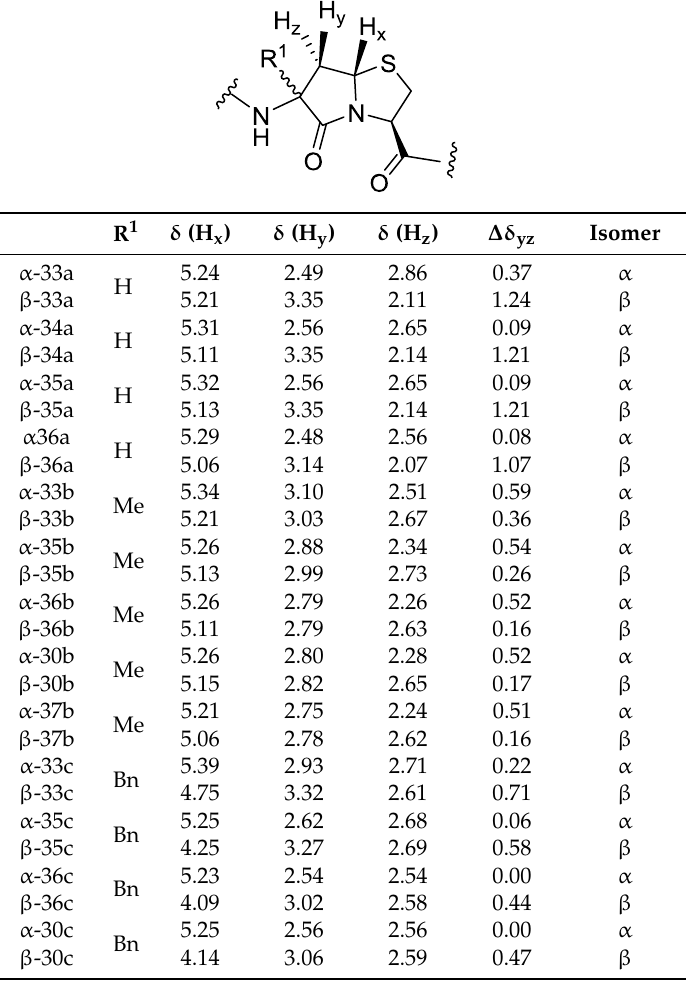
Table 3. Chemical shifts of H x , H y , and H z and the chemical shift differences between H y and H z in diastereomeric pairs.